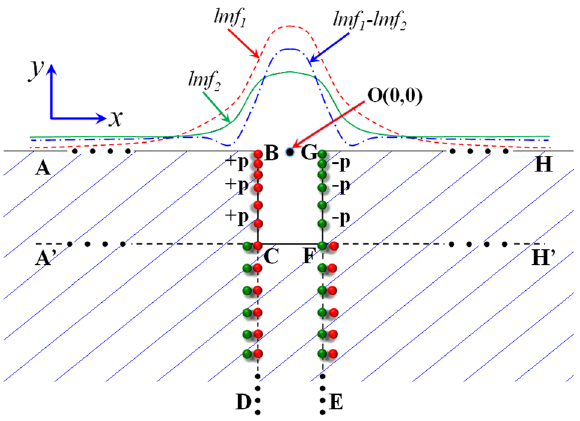
Figure 7. Formation mechanism of the leakage magnetic field.